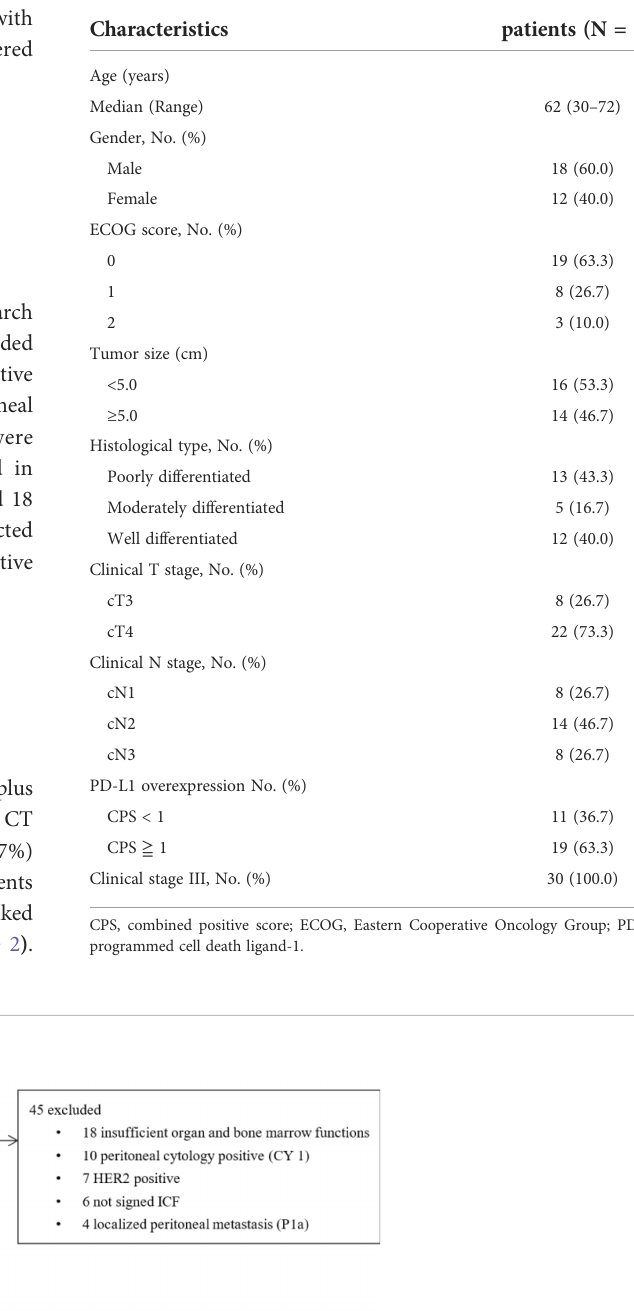
TABLE 1 Baseline demographic and patient